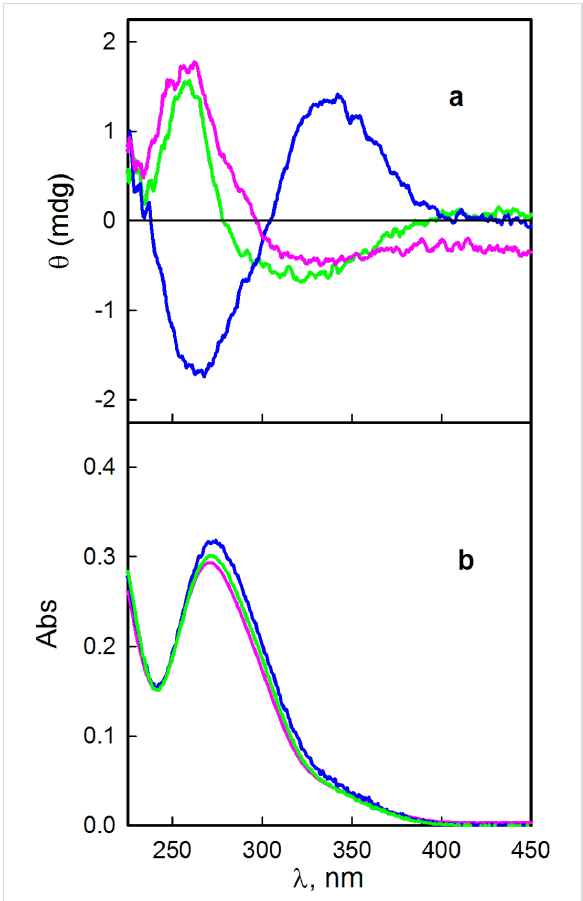
Figure 9: Induced circular dichroism (a) and UV–vis (b) spectra of 1 in the presence of β -CD (10 mM, green), DIMEB (2.5 mM, pink) and TRIMEB (10 mM, blue).